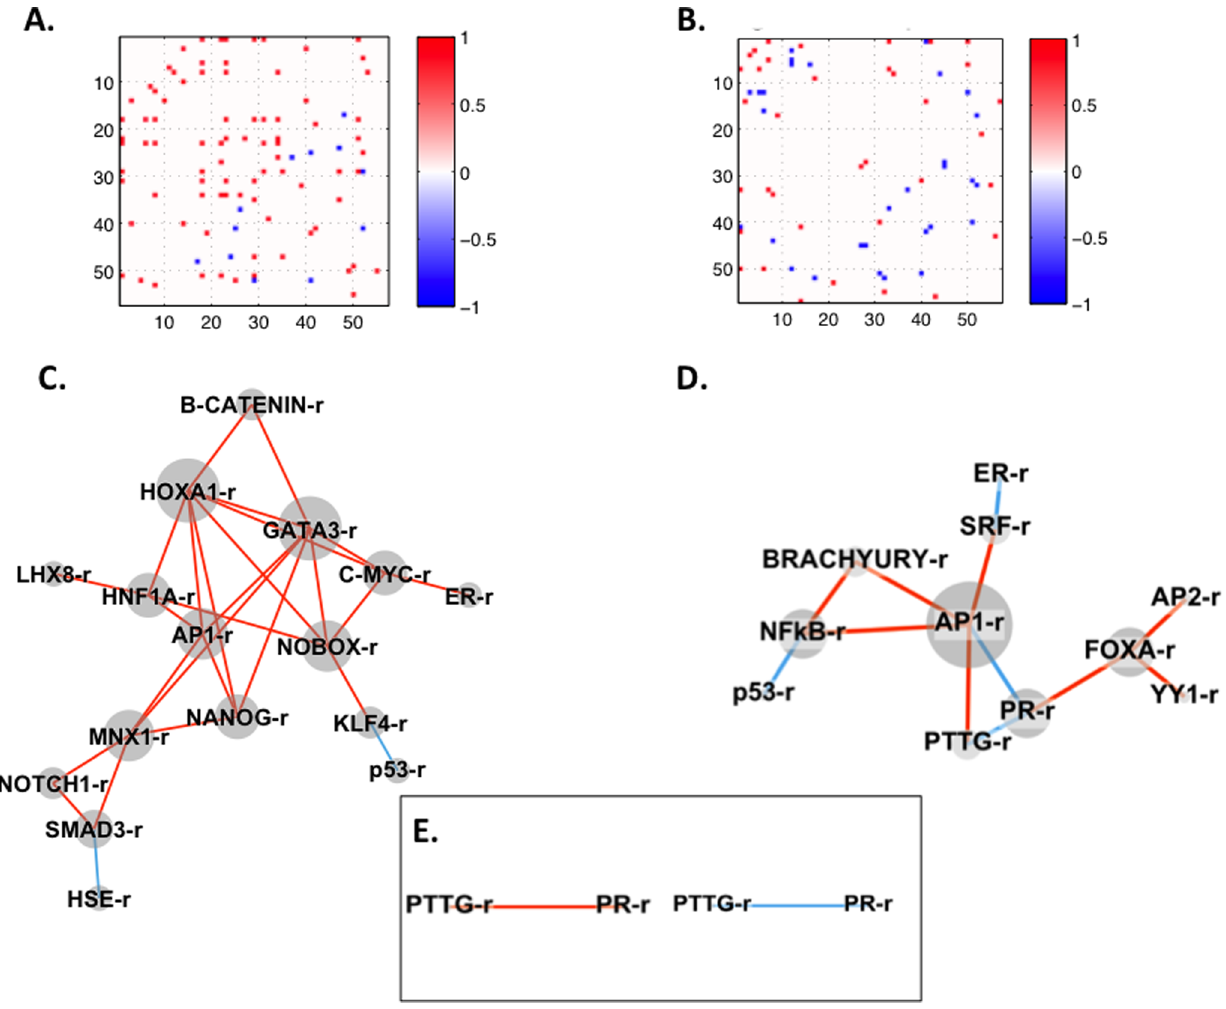
Figure 6. Pairwise correlations of dynamic TF activity patterns. A similarity index was defined to quantify the correlation of pairs of TF activities throughout the six-day experimental time course. A and B. Matrix for HMLE Twist ER cells treated with A. 4OHT or B. TGF- b 1. All 3080 possible pairwise correlations between the 56 TF reporters are plotted on the x- and y-axes with both axes listing all TF reporters as a number between 1 and 56 (only multiples of ten are shown). Red and blue points on the plots indicate significantly correlated pairs (significantly similar activity patterns identified by the similarity index calculation with significance defined as p # 0.05). Plots are symmetric along the diagonal between the upper left and lower right. C–D. Network representation of pairs of significantly similar (p # 0.05) activity patterns for HMLE Twist ER cells treated with C. 4OHT or D. TGF- b 1. The similarity index was applied to all pairs of TF reporters with significantly altered activity relative to vehicle (Figure 4). Networks show all significantly similar pairs of such TF activities with red lines indicating a positive (phase) correlation over the six-day time course and blue indicating a negative (anti-phase) correlation in activity pattern. TF activities that were significantly altered compared to vehicle in Figure 4 but did not have a significantly similar activation pattern to any other TF activity in the dataset are not represented in networks. E. Common motifs of TF reporters with significantly similar activity in both HMLE Twist ER models at p # 0.05. For the AP1-r/NANOG-r/PR-r/PTTG-r motif, connectivity in 4OHT-treated cells is shown on the left and connectivity in TGF- b 1-treated cells is shown on the